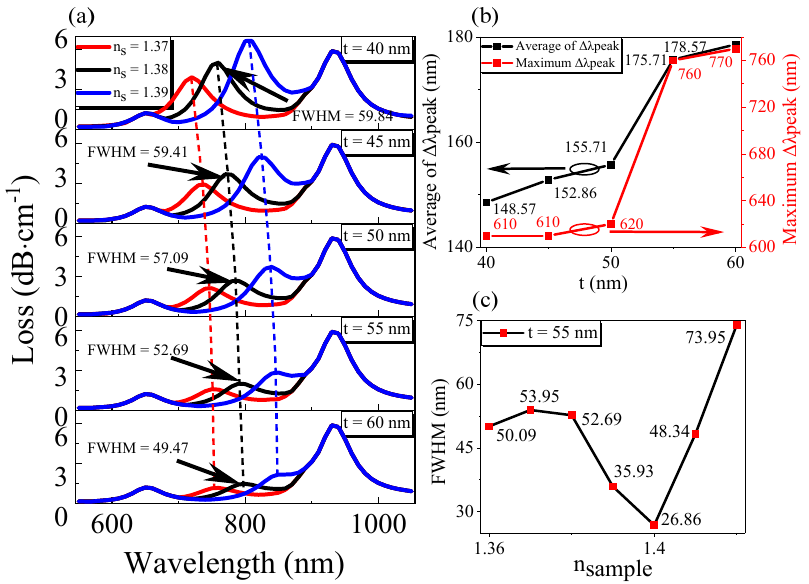
Figure 4. Optimization of graphene layer number of plasmonic optical fiber sensor under the con- dition of the same T, H and different refractive index of liquid to be measured: ( a ) The variation of transmission loss with wavelength under different graphene layers; ( b ) The change of resonance wavelength with the refractive index of the liquid to be measured under various layers of gra- phene; ( c ) The variation of the average resonant wavelength shift with the number of graphene layers under the different refractive index of the liquid to be measured.